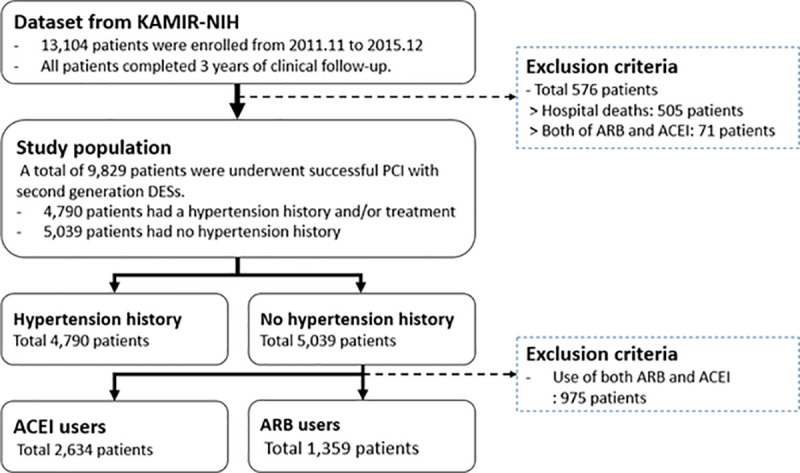
Flow chart of this study.